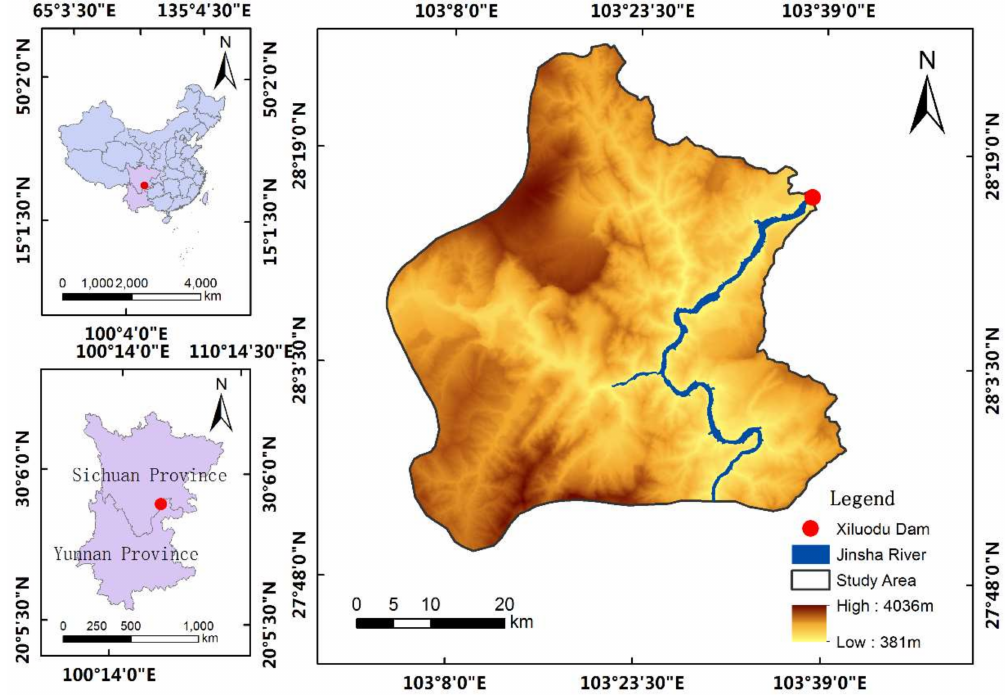
Figure 1. Location of the Study